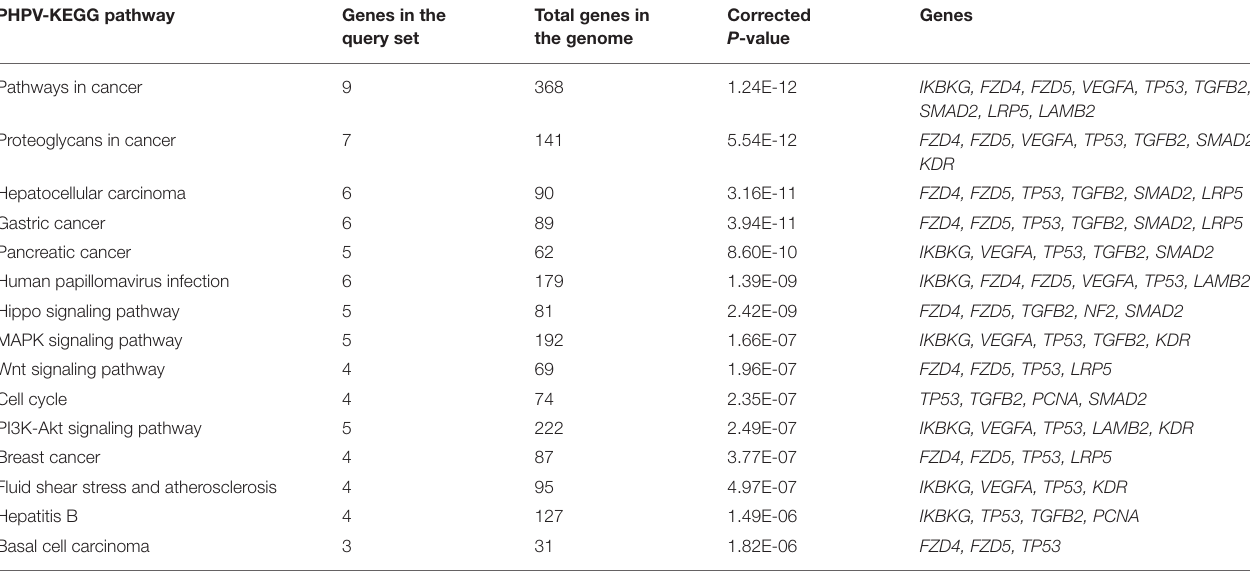
TABLE 2 | Top 10 enriched Kyoto Encyclopedia of Genes and Genomes (KEGG) pathways assigned to the text mining genes. PHPV-KEGG pathway Genes in the query